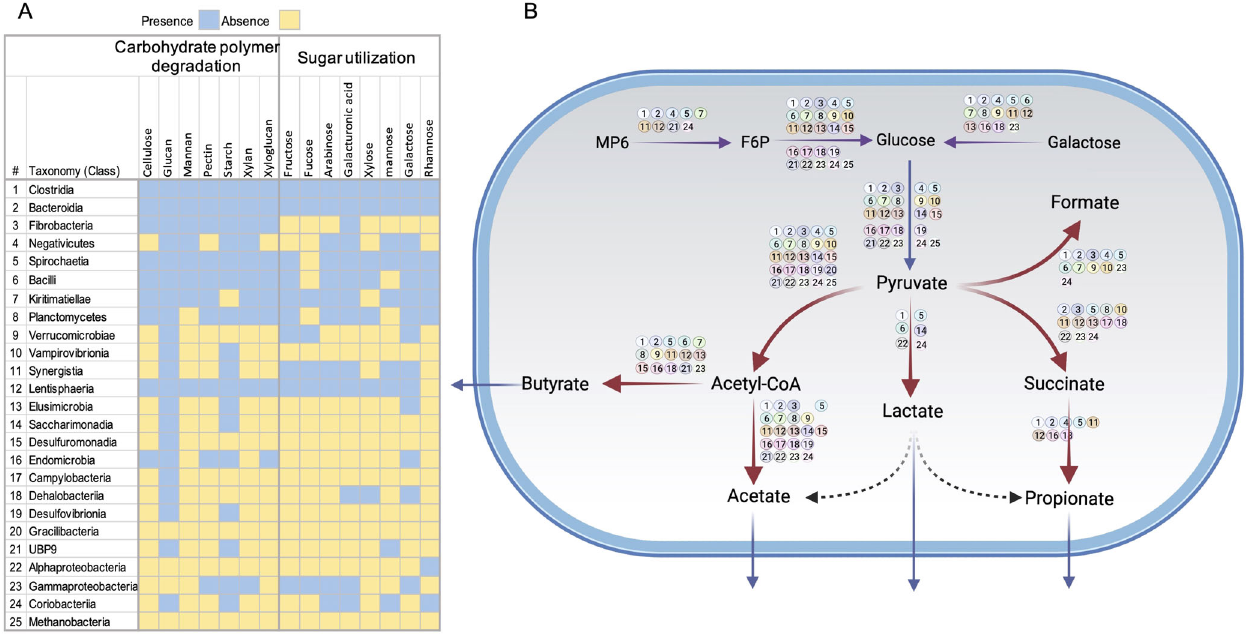
Fig. 5 Metabolic characterization of RUIs. RUIs were characterized with respect to their abilities for major polysaccharides degradation, sugar utilization and fermentation. RUIs were grouped into class level taxonomic clades based on taxonomies inferred by GTDB-Tk. Metabolic pathways were reconstructed based on the presence of key marker genes of each metabolic pathway using KOfam annotations. The details of Hidden Marcov Model (HMM) pro fi les searched are presented in Supplementary Data